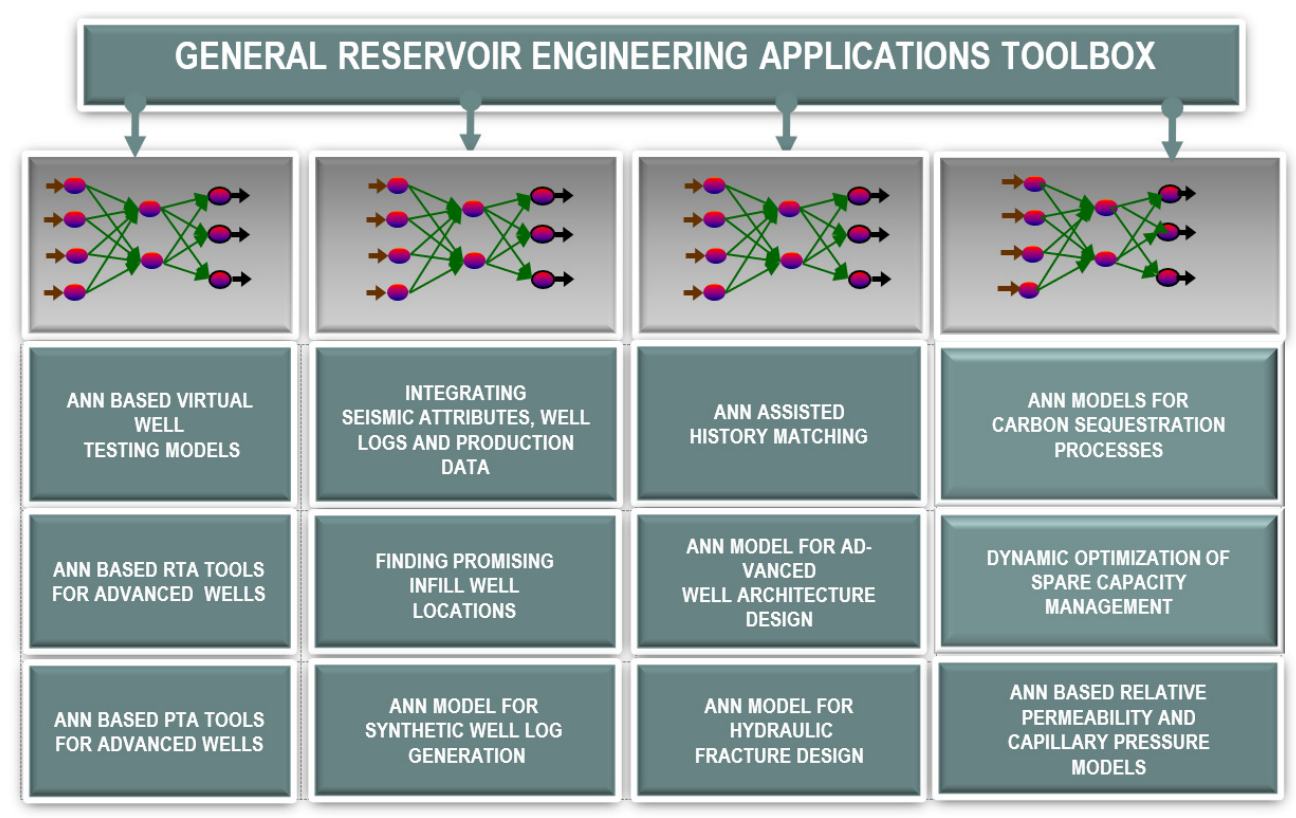
Figure 6. General reservoir engineering applications toolbox.